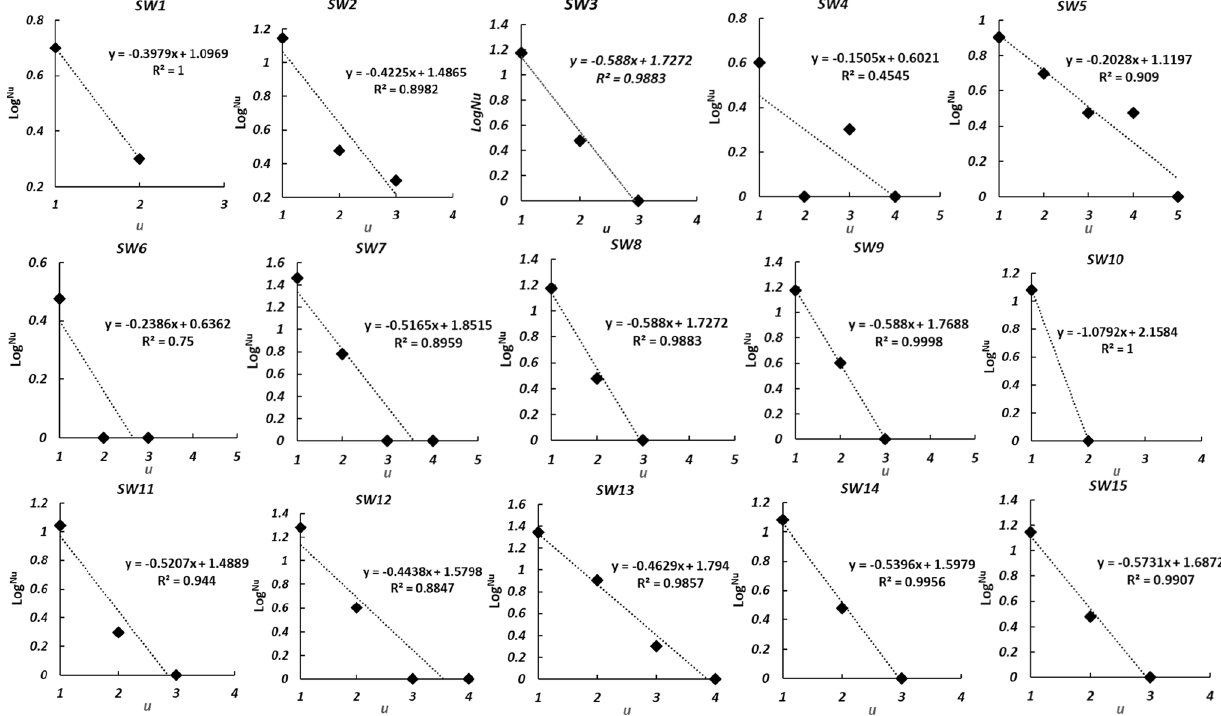
Fig. 4 Regression of N u against u for each